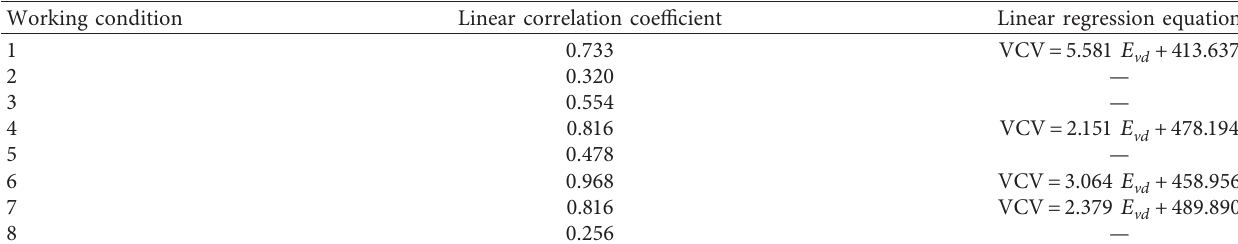
vd mean and the VCV mean.